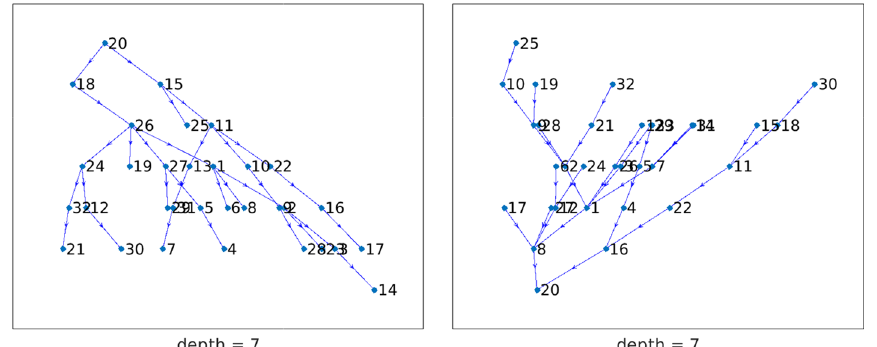
Fig. 8 Network ibm32: the out-tree (left) and the in-tree (right) rooted at vertex v 20 . These trees have maximal chain length ℓ = 7